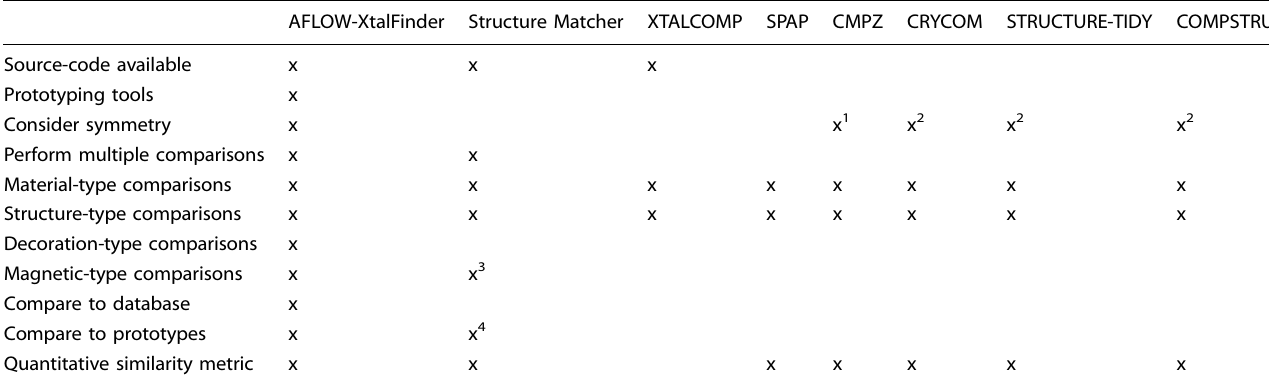
Table 2. Functionalities of comparison codes speci fi c to high-throughput analysis and structure prototyping. This tabulation is not exhaustive; many programs offer additional analyses, such as fragment/molecular comparisons, and are outside the scope of this work. 1 : optional symmetry input. 2 : requires symmetry input. 3 : Structure Matcher matches magnetic structures with opposite spins ( SpinComparator function). 4 : Structure Matcher compares to the AFLOW Prototype Encyclopedia partially, as it does not provide the internal degrees of freedom for the